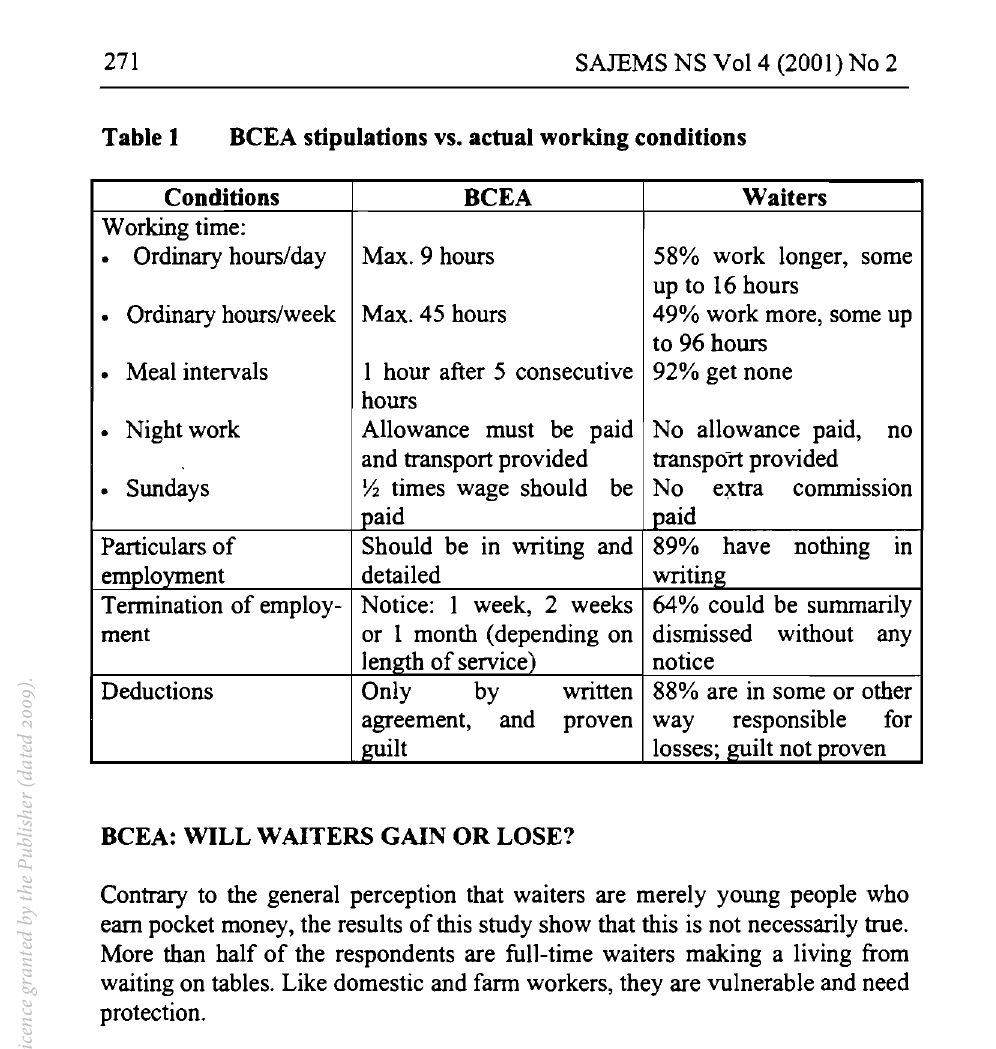
BCEA stipulations vs. actual working conditions